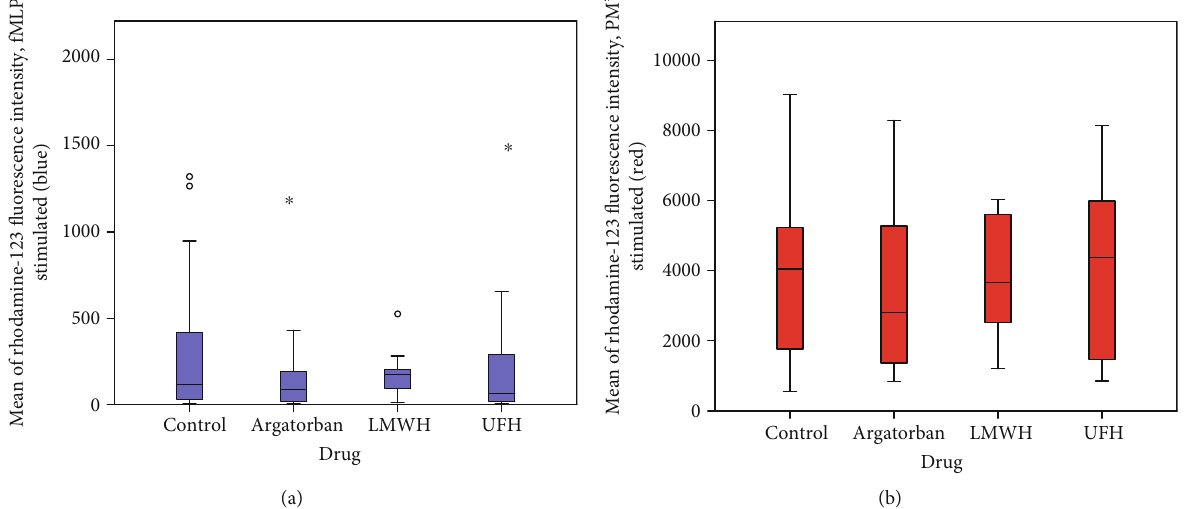
Figure 4: FACS analysis of ROS production: comparisons between fMLP (blue) and PMA- (red-) stimulated explorations of the four groups showed no di ff erences. LMWH: low-molecular-weight heparin; UFH: unfractionated